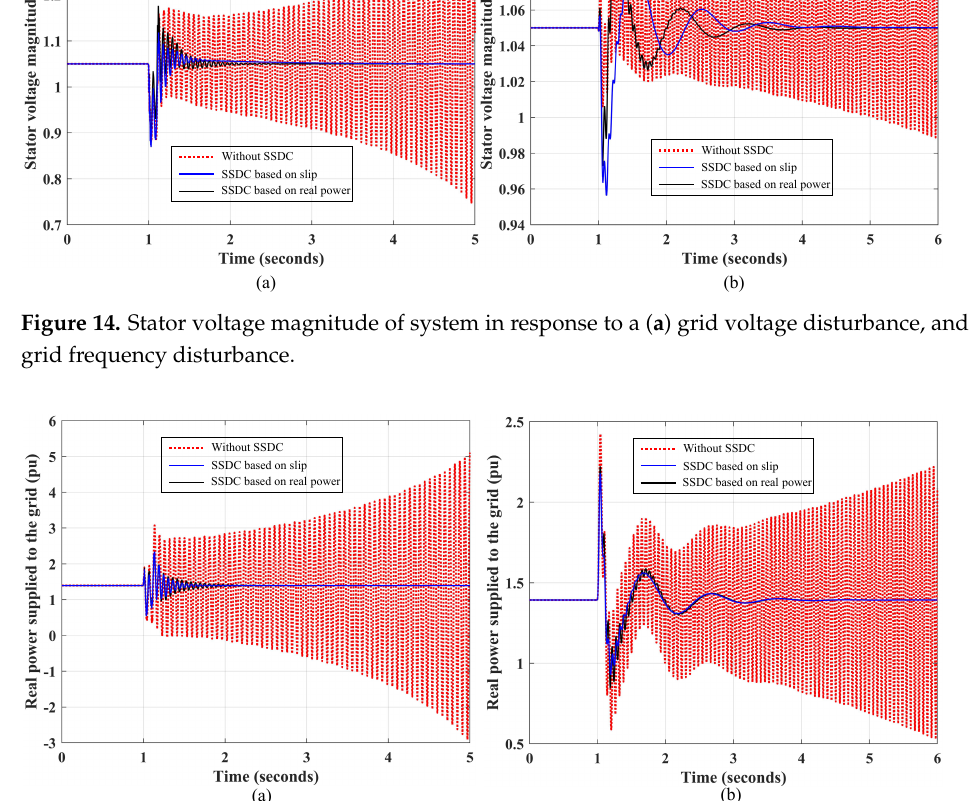
Figure 15. Real power delivered in response to a ( a ) grid voltage disturbance, and ( b ) grid frequency disturbance.